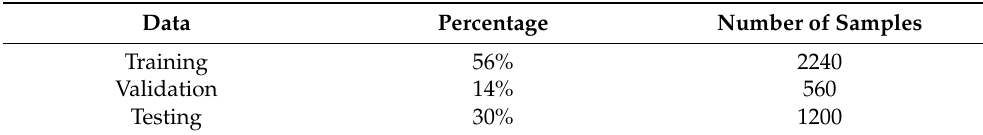
Table 2. Dataset split ratio for the Rossler model.